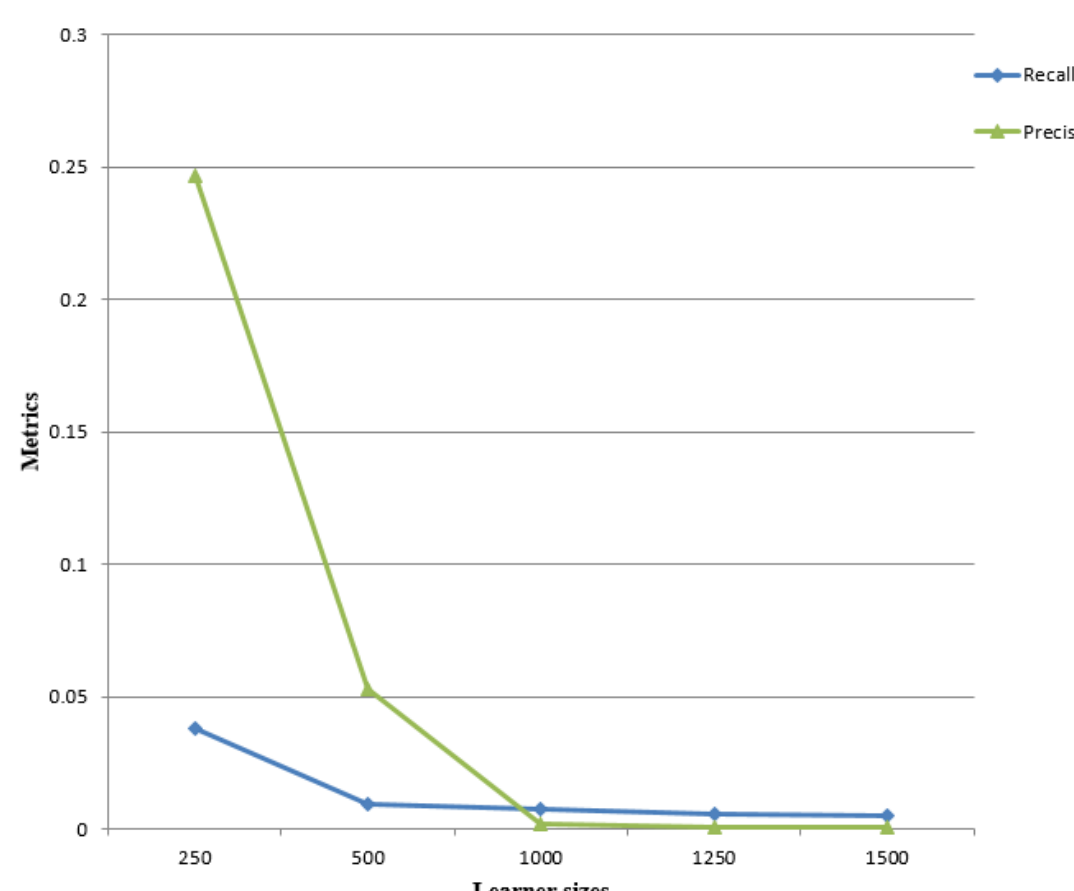
Figure 8. Size of the recommendation list versus precision.